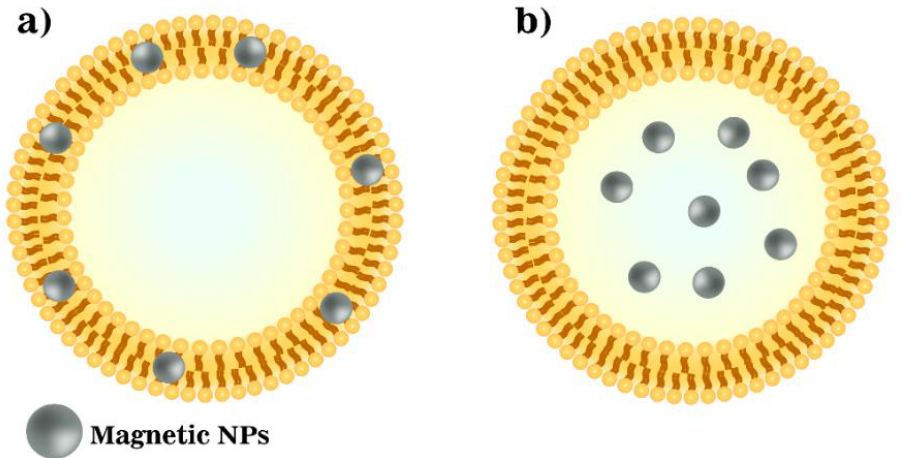
Figure 3. Schematic illustration of two types of magneto-liposomes: ( a ) hydrophobic NPs in a bilayer of magneto-liposomes; ( b ) hydrophilic magnetic NPs in the core of magneto-liposomes. Table 1. List of all studies using magneto-liposomes for magnetic resonance imaging (MRI) applications with a summary of their experimental data (sizes of IO NPs and their locations in liposomes, liposomal formulation, concentration ranges used for the determination of r 2 , maximum r 2 values and in vivo conditions). Chol is abbreviation for cholesterol.